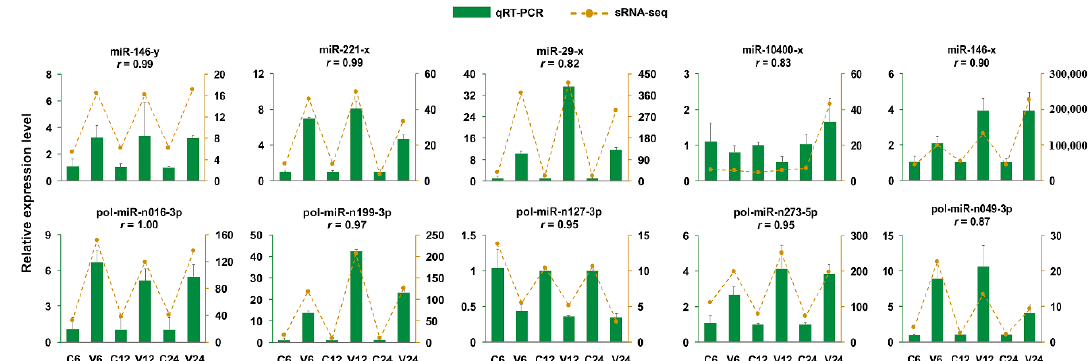
Figure 3. Validation of differentially expressed miRNAs (DEmiRs) by qRT-PCR. The expression profiles of 10 DEmiRs were evaluated by qRT-PCR and compared with that obtained by sRNA-seq. Results are shown as means ± standard deviation ( n = 3). For each DEmiR, the correlation coefficient ( r ) between the results of qRT-PCR and sRNA-seq is indicated.